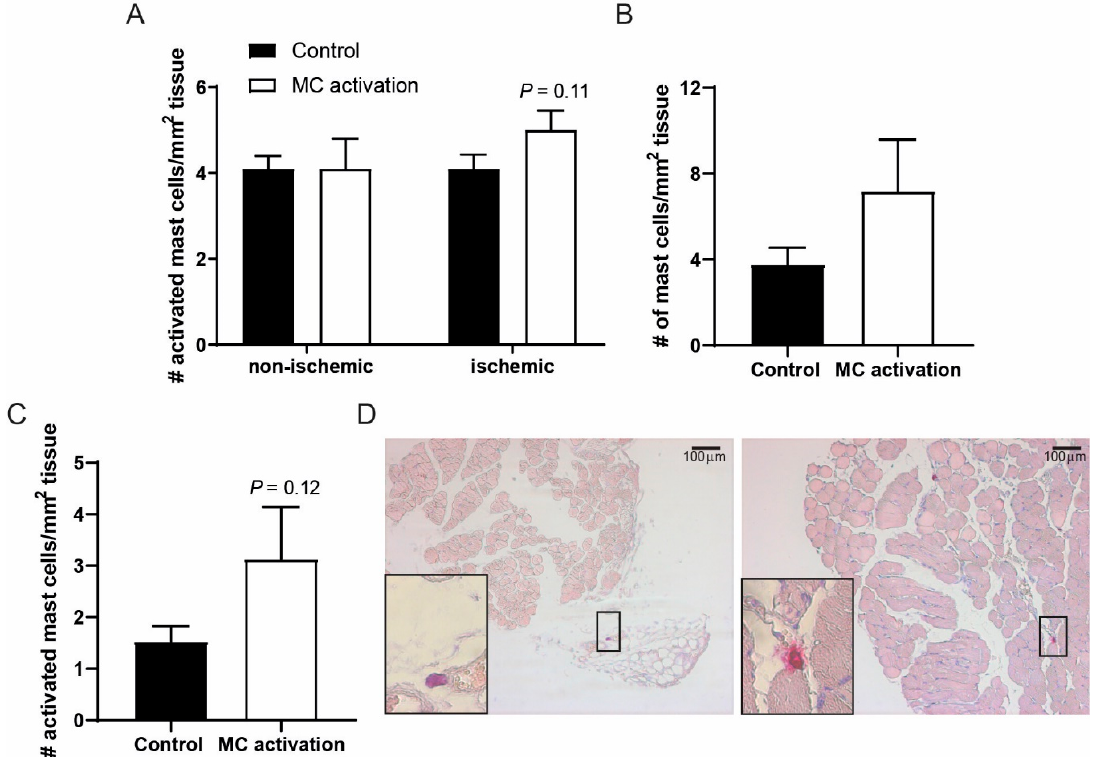
Figure 4. Activated mast cell numbers in muscle tissue of the ischemic hind limb. ( A ) The number of activated mast cells as measured by histology in the ischemic vs. non-ischemic adductor muscles of mice in which mast cells were activated compared to control mice at day 9 after the induction of ischemia. ( B ) Total mast cell numbers per mm 2 of ischemic soleus muscle tissue. ( C ) Number of activated mast cells per mm 2 of soleus muscle tissue at day 9 after ligation. ( D ) Representative overview images of the soleus muscles with a resting (control, left) and an activated mast cell (dinitrophenyl hapten, DNP, right) in high-magnification inserts. Mast cell activation did not result in muscle hypertrophy, analyzed in both the ischemic and non-ischemic adductor muscles of the control and DNP-group at day 9 and day 28 after femoral artery ligation (data not shown).